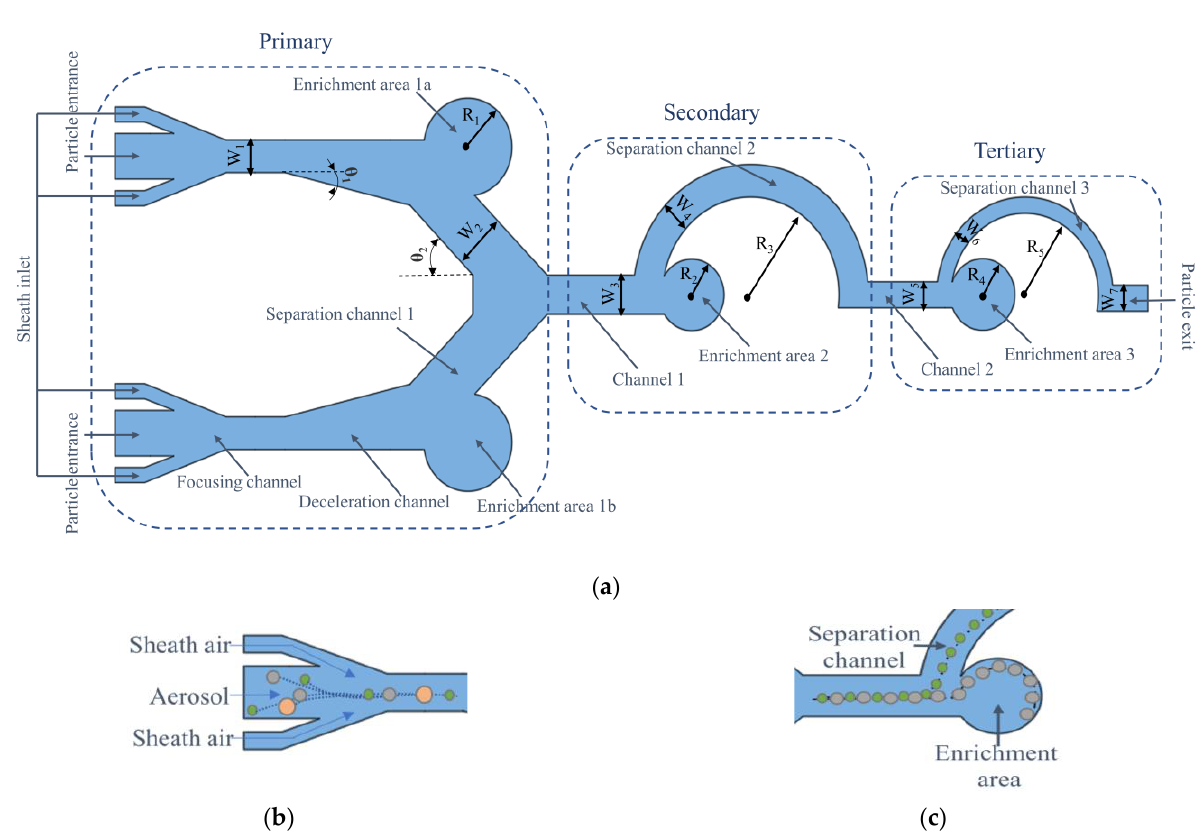
Figure 1. ( a ) The two-dimensional structure of the microfluidic chip. The enrichment areas 1a and 1b in the chip collect particles with larger particle size in the air, enrichment area 2 collects Magnaporthe grisea spores, enrichment area 3 collects Ustilaginoidea virens spores, and particles with smaller particle size are discharged from the outlet. ( b ) Schematic diagram of sheath flow working principle; ( c ) schematic diagram of separation channel working principle.